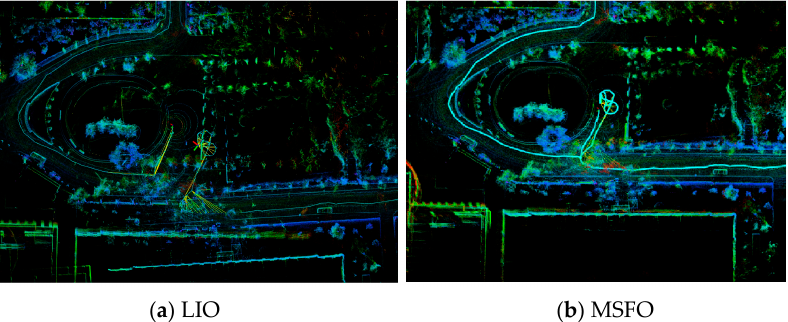
Figure 11. Point cloud details: error accumulation occurs when LIO returns to the origin and leads to point cloud stratification. Meanwhile, this situation does not occur in MSFO.